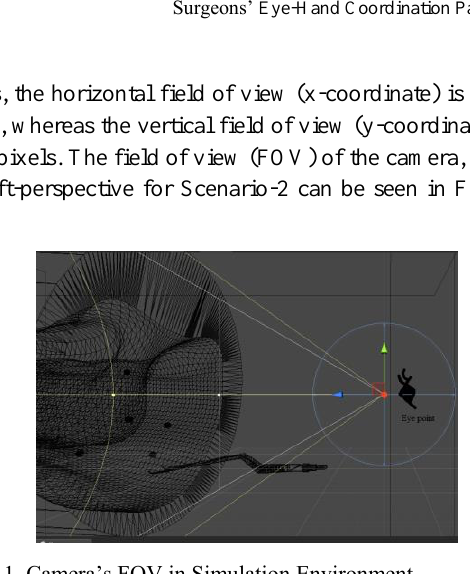
Figure 1. Camera’s FOV in Simulation Environment